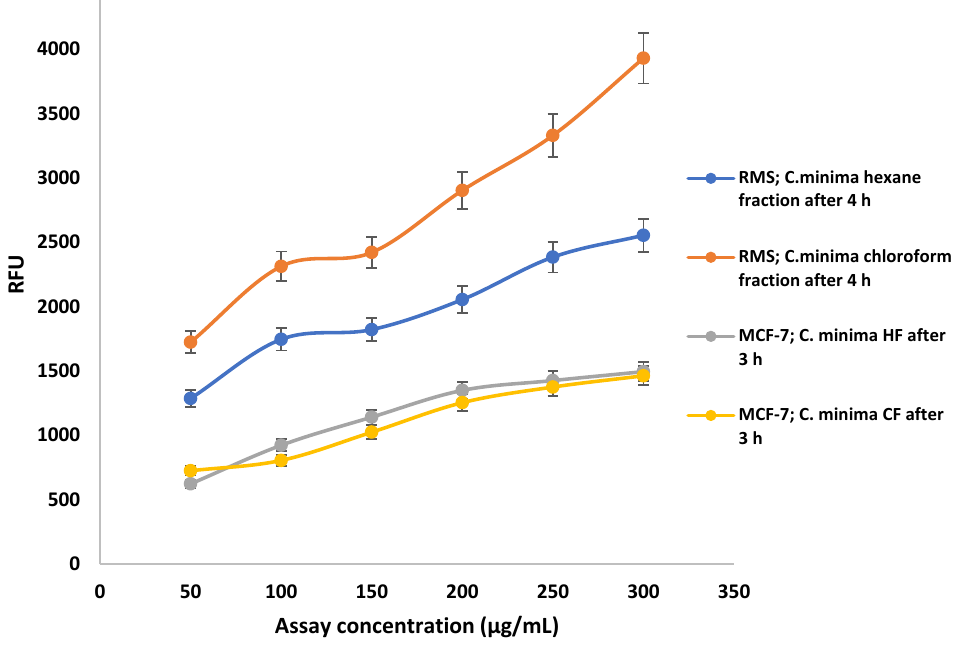
Figure 10. Dose-dependent activation of caspase 3/7 in RMS and MCF-7 cells treated with hexane, chloroform fractions of C. minima . Data are expressed as mean ± SD of triplicates.